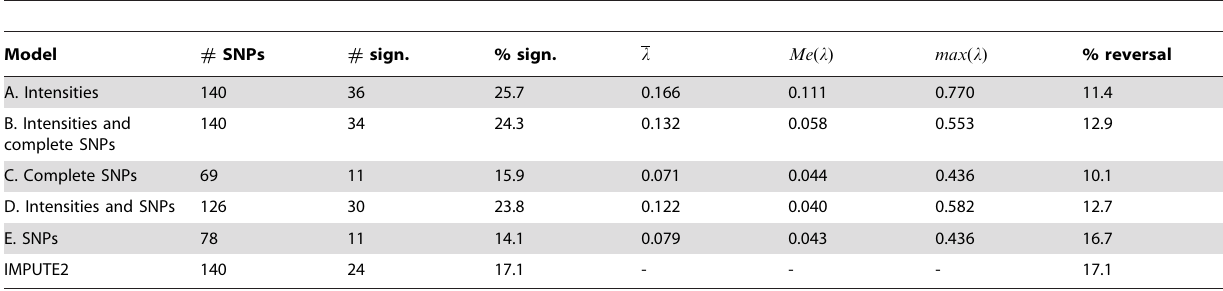
Table 3. Number of imputed SNPs, number and percentage of significant SNPs with missings imputed, mean, median and maximum of the fraction of missing information ( l ) for multinomial logit models with five different sets of predictors.